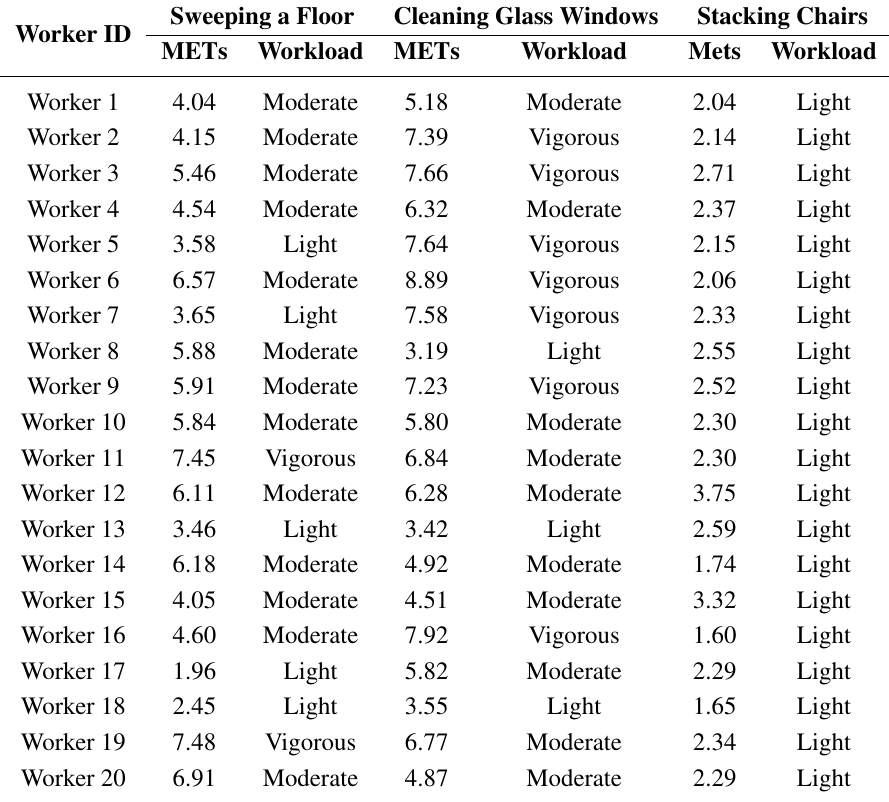
Table 8. Selected higher results and their corresponding